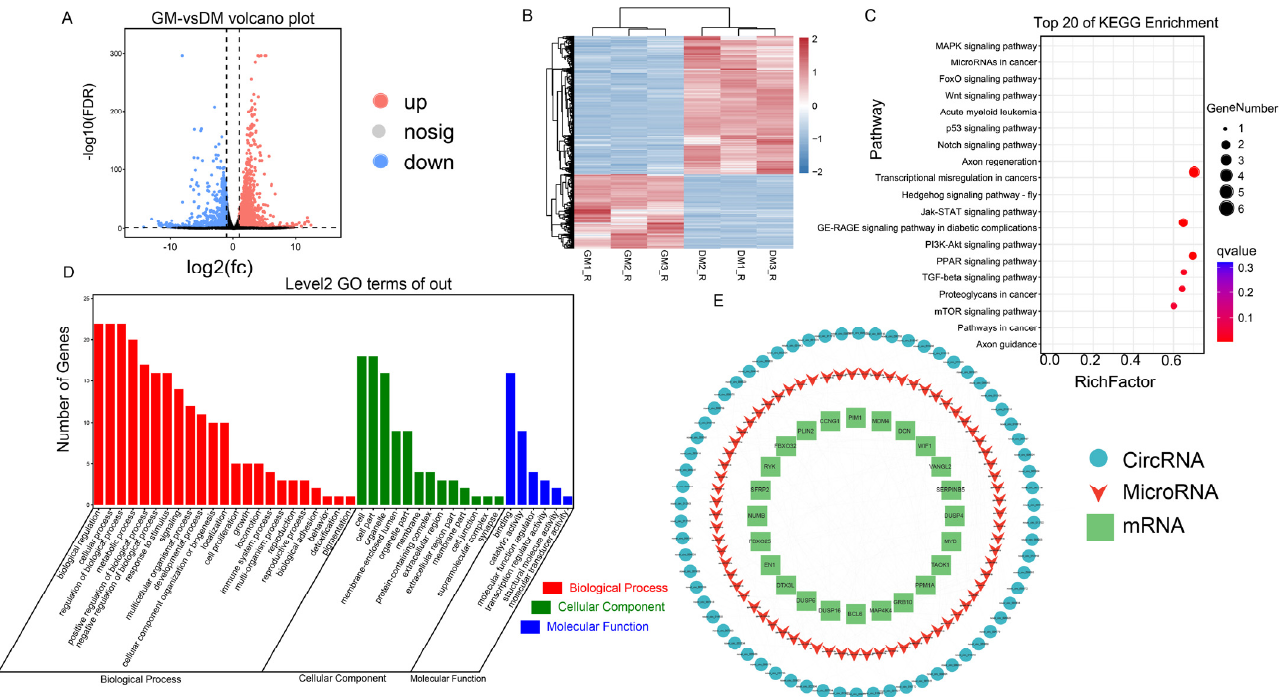
Figure 2. Overview of the ribosomal footprinting and circRNA–miRNA–mRNA interaction network analysis. ( A , B ) Volcano plot ( A ) and heatmap ( B ) of differentially expressed mRNAs between GM relative to DM in chicken myoblasts. ( C , D ) GO functions ( C ) and KEGG pathways ( D ) analysis of differentially expressed mRNAs. ( E ) The circRNA–miRNA–mRNA regulatory axes network associated with muscle development, with blue circles representing circRNAs, red triangles representing miRNAs, and green rectangles representing mRNAs.